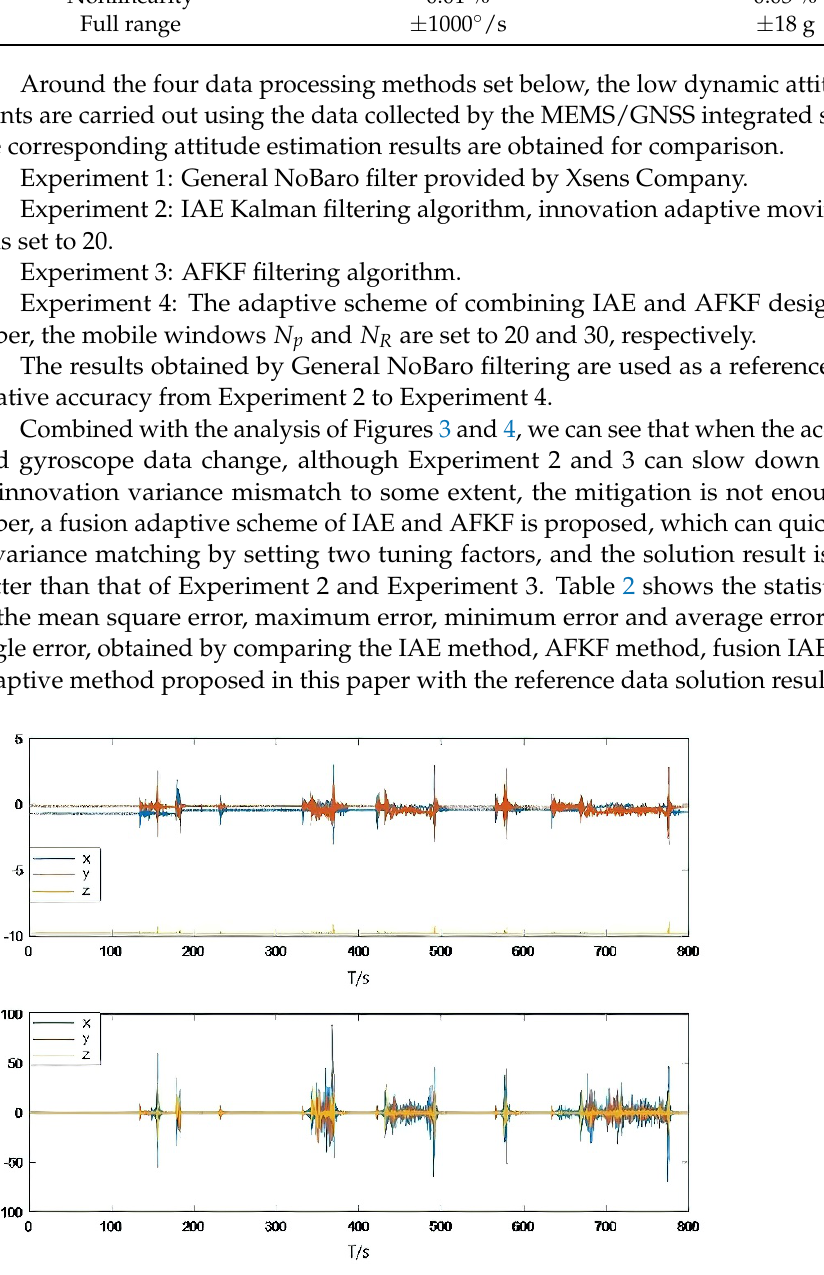
Figure 3. Accelerometer data and gyroscope data .